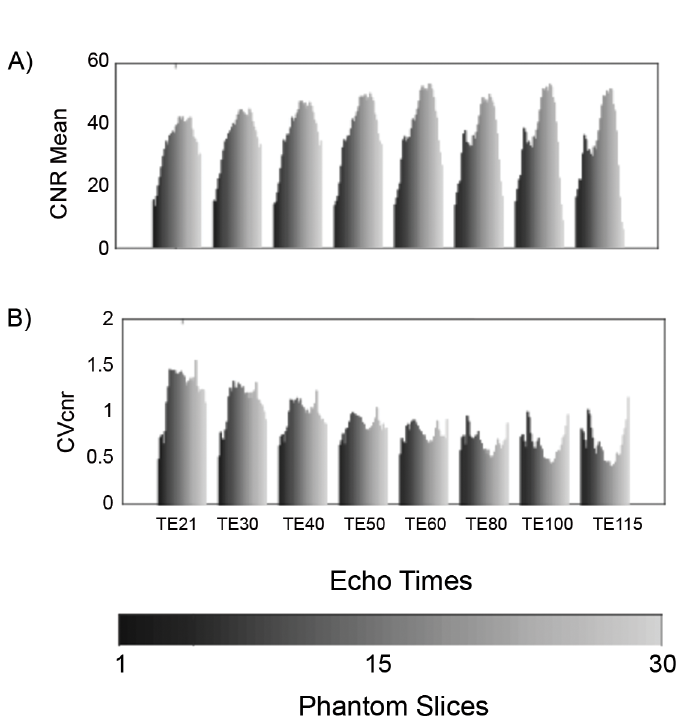
Fig 7. CNR and CV CNR dependence on slice position for EPI scans. A) CNR mean and B) CVcnr plotted across phantom slices for EPI scans at various echo times (TR/TE/FA = 4000ms/21ms-115ms/90°, matrix = 64x64). There is a greater variation of CNR in EPI images compared to the GRE (Fig 6) across the slices and within the